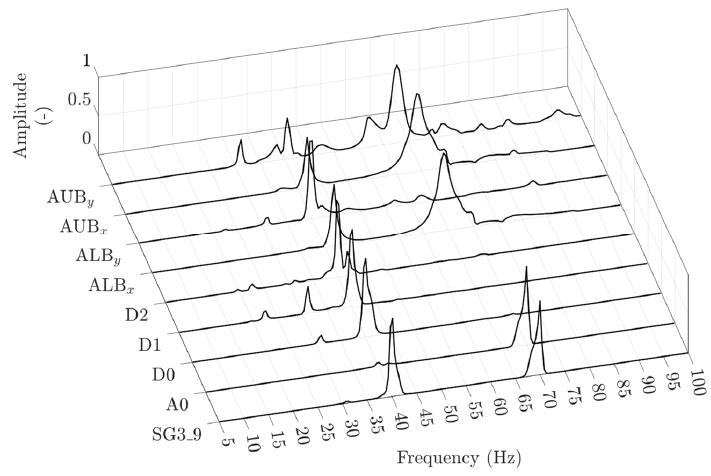
Figure 11. Maximum normalized spectra of the STFT measured from several sensors when the disk was excited with a chirp in the range of 0–100 Hz.